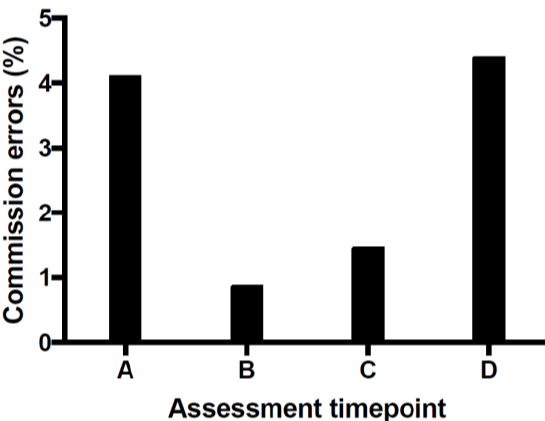
Figure 1. Mean commission errors as a percentage of total no-go trials ( n = 2). The percentage of commission errors reduced during the active treatment phase and then rebounded post-treatment. Post-treatment is after the three weeks of sham stimulation. A: Pre-treatment; B: After 3 weeks of active transcranial direct current stimulation (tDCS); C: After 6 weeks of active tDCS; D: Post-treatment (6 weeks active + 3 weeks sham).